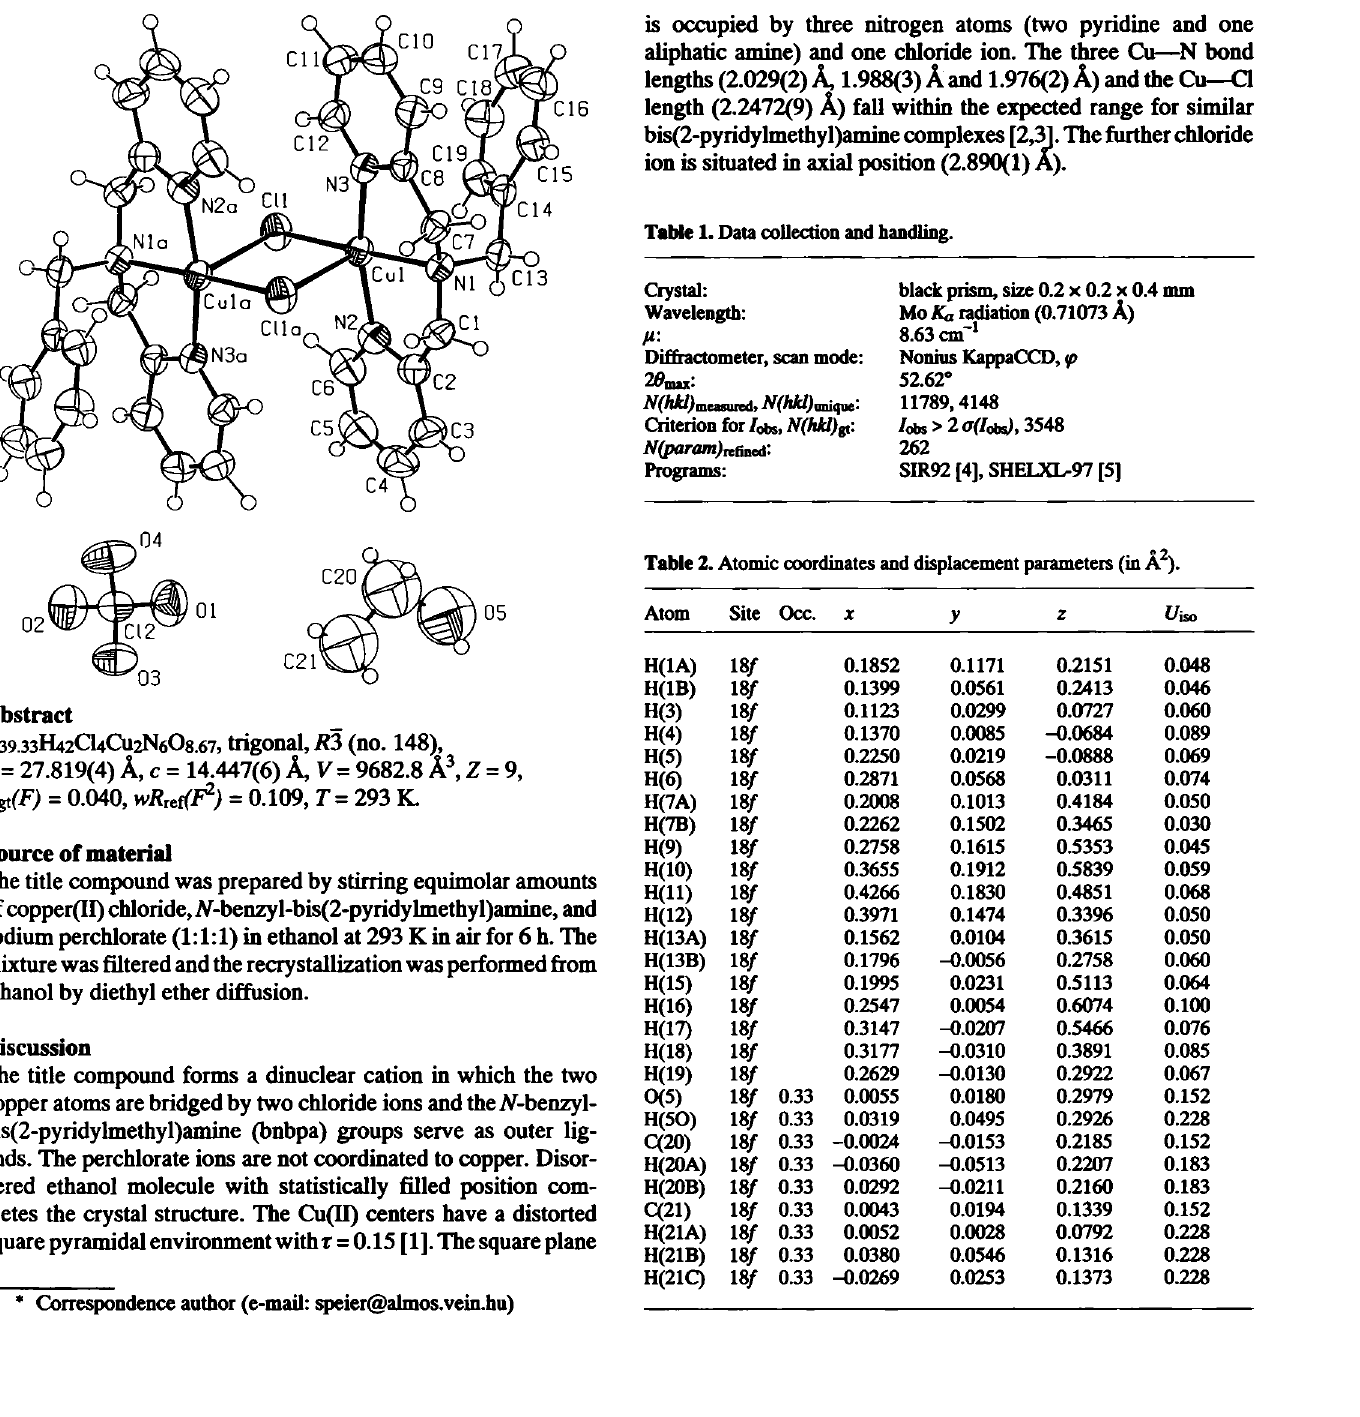
Table 1. Data collection and handling.